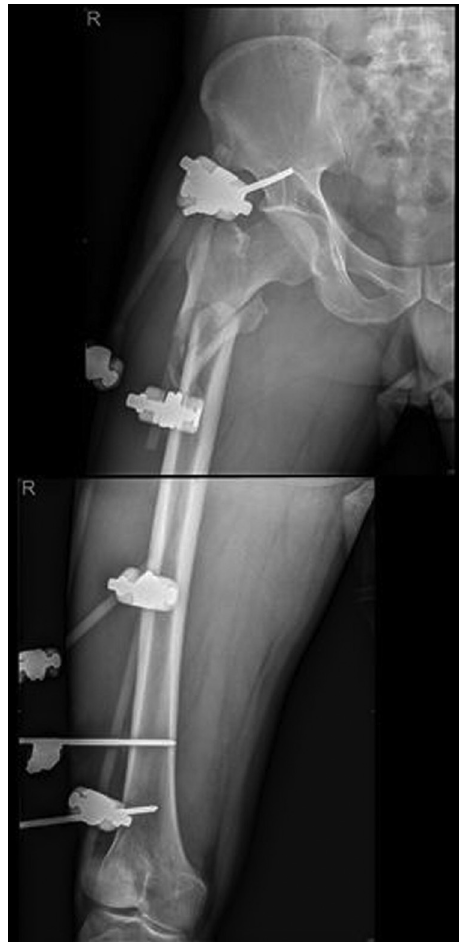
Figure 4: Postoperative X - ray showing good alignment following external fi